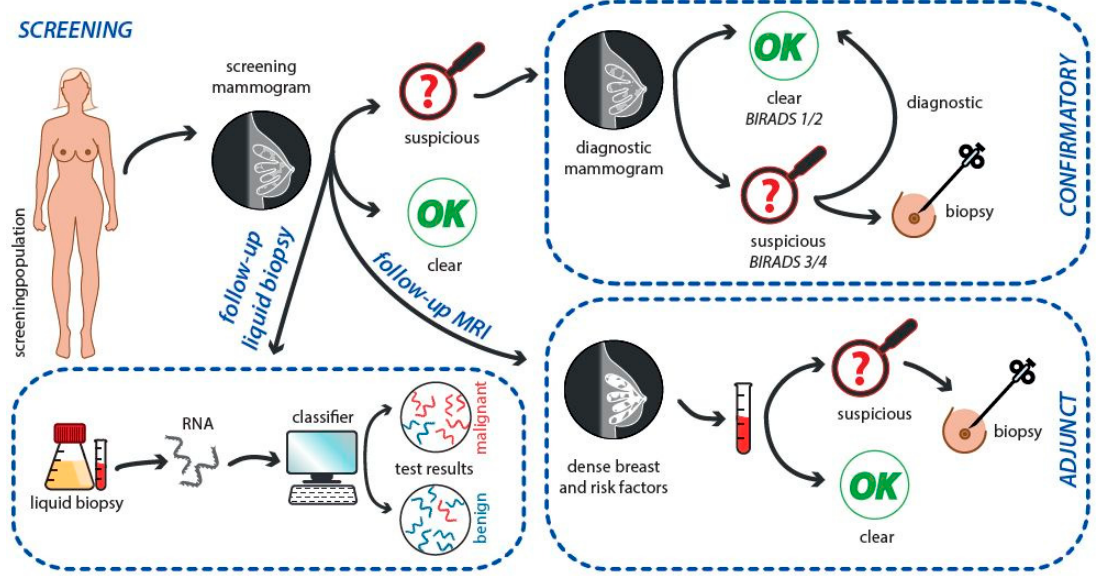
Figure 3. Liquid biopsy miRNA adjunct to conventional screening of BC within personalized diagnosis and improved management of the disease.